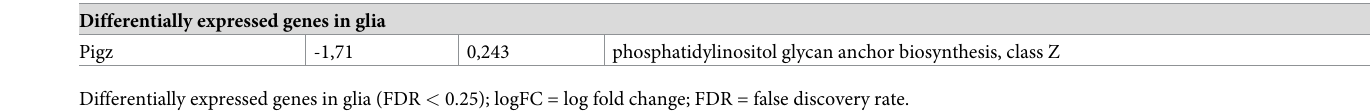
PLOS ONE | https://doi.org/10.1371/journal.pone.0226575 December30,